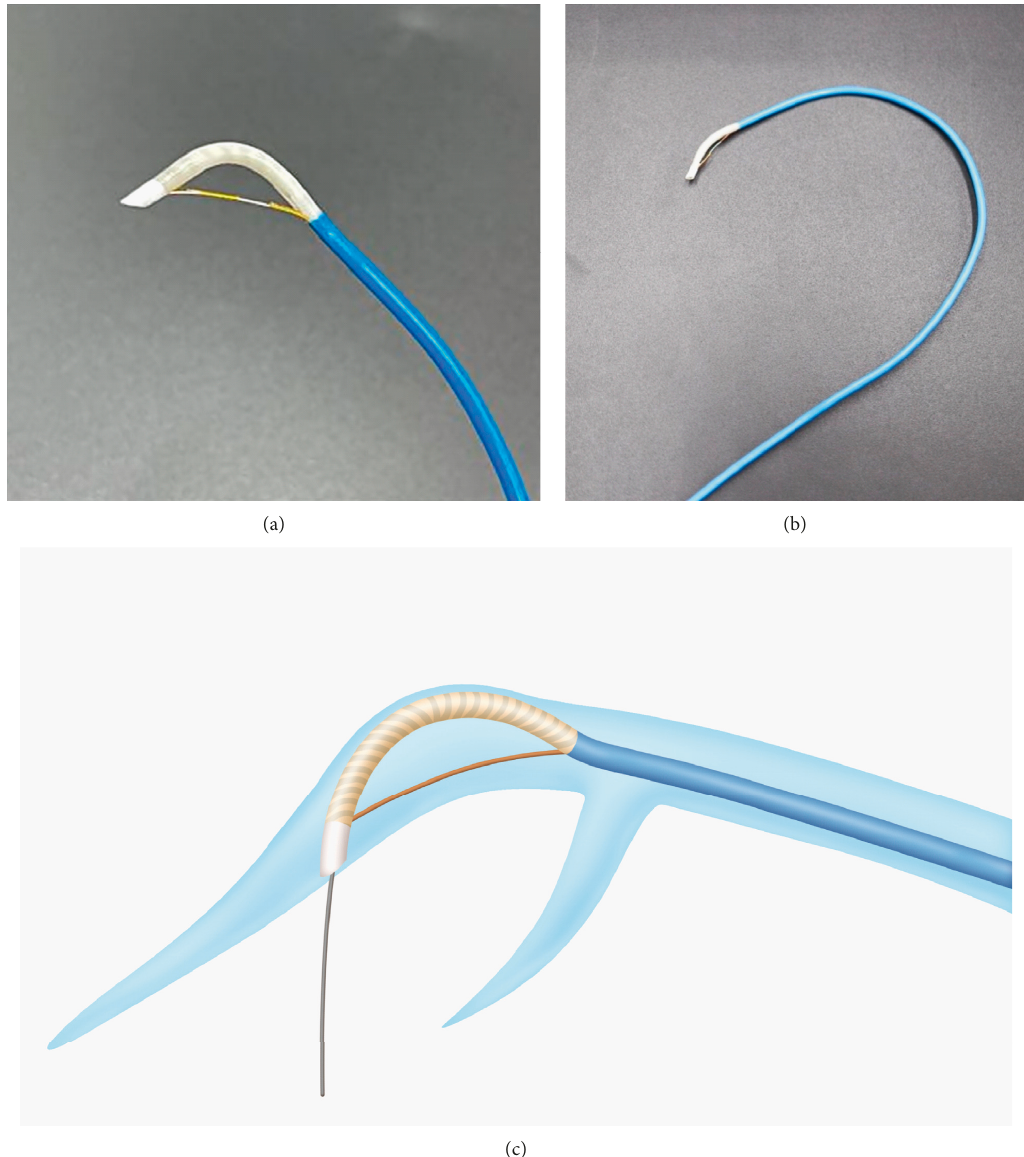
Figure 2: The Cobra catheter design. (a) The distal tip of the Cobra catheter is oblique-shaped to establish complete contact with the vessel wall. The wire outside the sheath creates a bending moment when the wire is pulled by the rotating handle. (b) The preshaped catheter shaft provides an appropriate degree of angulation and torquability to guide the guidewire towards the desired direction. The curve matches the prospective shape of the coronary sinus. (c) This design provides an adequate backup force to directly engage the guidewire through the punctured vessel